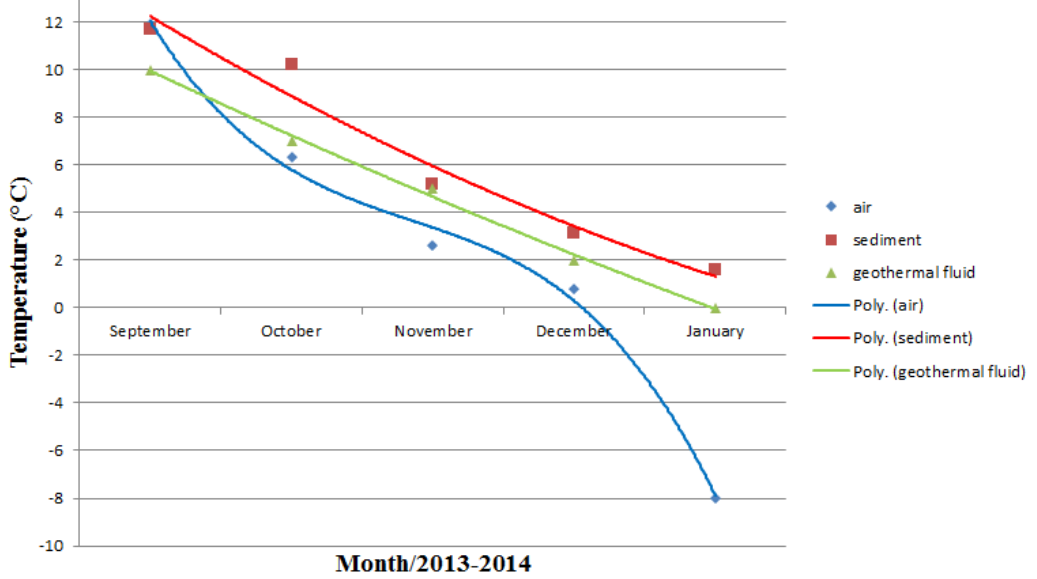
temperatures of the sediment were increasing by up to 14 °C from March to August. The greatest difference in sediment temperatures is between April and May. The heat loading in the sediment layer takes place along the whole area from the shore to the distance of 300 m, which can be observed as a constant curve without any slope in July and August. The difference in temperatures in July and Figure 6. Temperatures of air, sediment and geothermal fluid in measurement period 2013–2014. August is about 3.5 °C. The effect of the Sun is obvious.